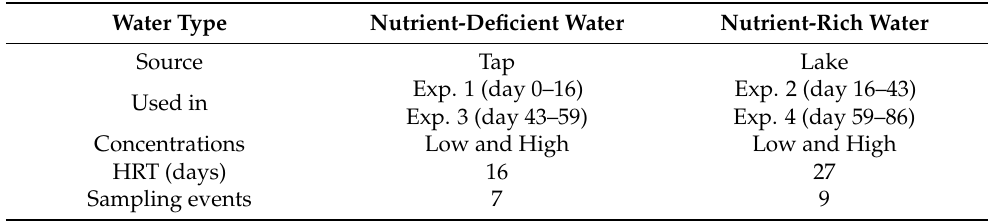
Table 1. Operational conditions in the